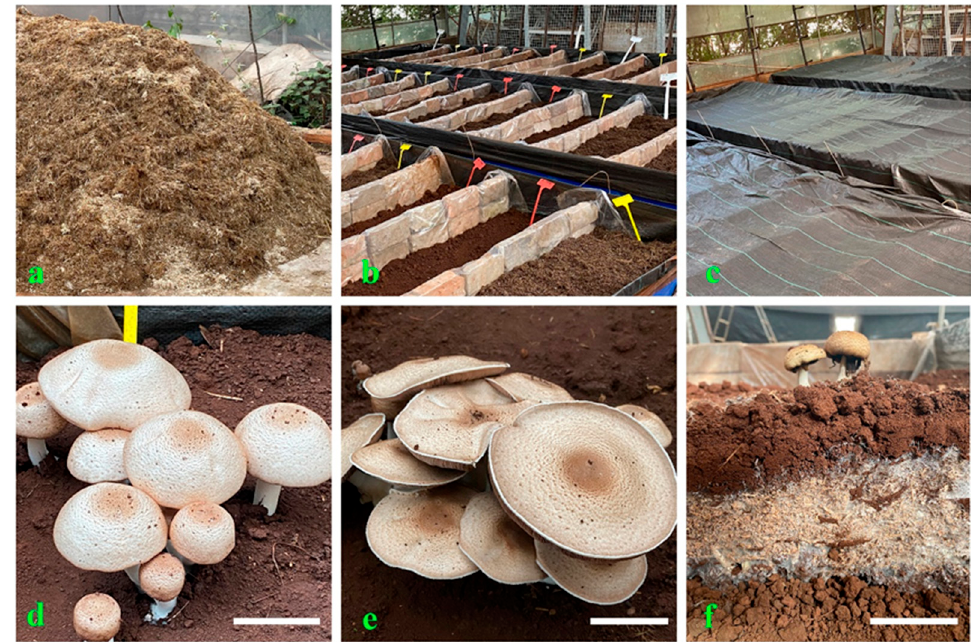
Figure 2. The glasshouse experiment investigating the effects of cultivating Agaricus subrufescens , and subsequent basidiocarp production, for soil amendment. ( a ) composting process; ( b ) experimental layout from the four different treatments; ( c ) covering of the different treatments during the mycelial colonization of the compost; ( d ) unmatured basidiocarps; ( e ) mature basidiocarps; ( f ) soil and compost profile during the incubation period. Scare bar: d and e , 5 cm; f , 8cm.